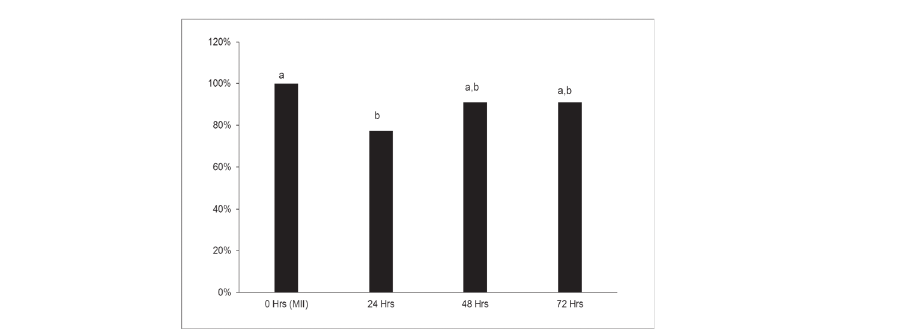
Figure 2. Determination of endogenous H 2 S production during porcine oocyte aging. Oocytes were cultivated to metaphase II (MII). Hydrogen sulfide production was carried out using the spectrophotometric method. MII oocytes, as well as oocytes exposed to prolonged cultivation for 24, 48 and 72 hours, were examined. The results of the measurement are presented as a ratio relative to the MII oocyte group. a, b Statistically significant differences in spontaneous hydrogen sulfide production are indicated by different superscripts (P < 0.05). Each experiment was repeated four times. The total number of oocytes in each sample was